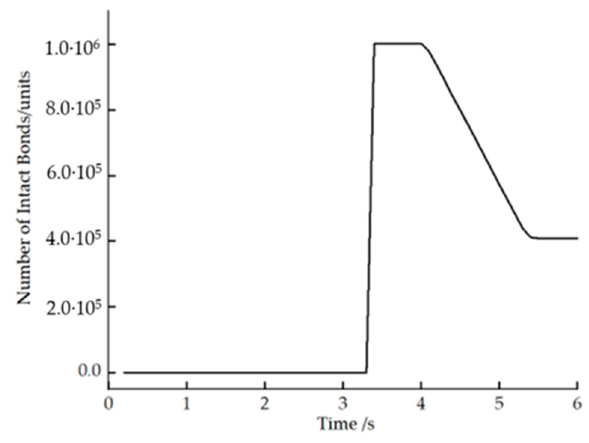
Figure 10. Changes in the number of soil connection bonding bonds during the operation .